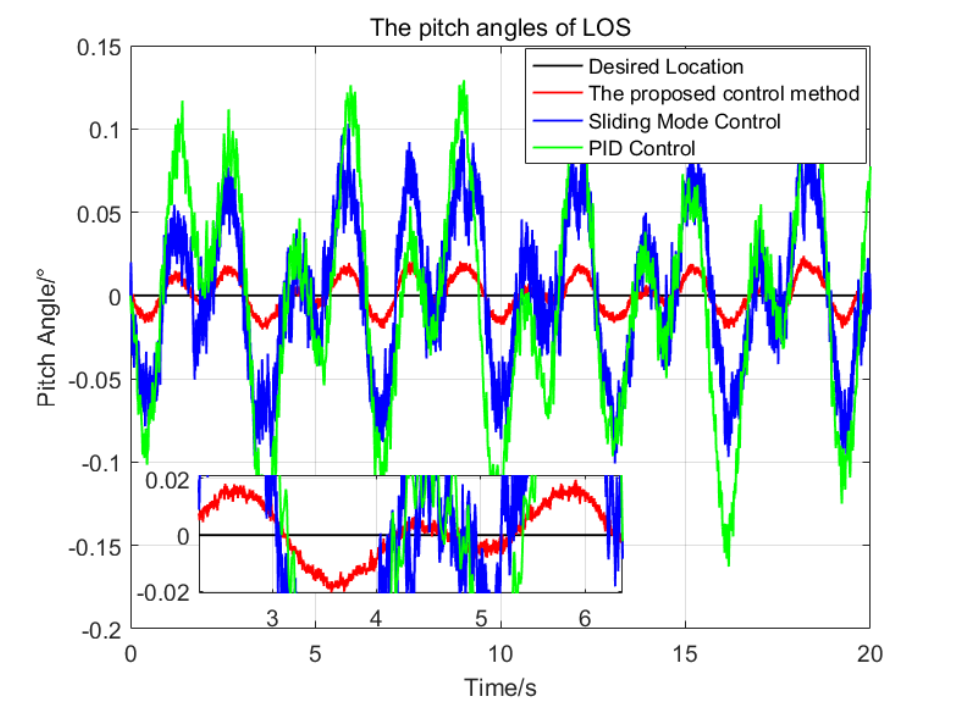
Figure 4. The comparison of the pitch angles of the LOS generated by the three control